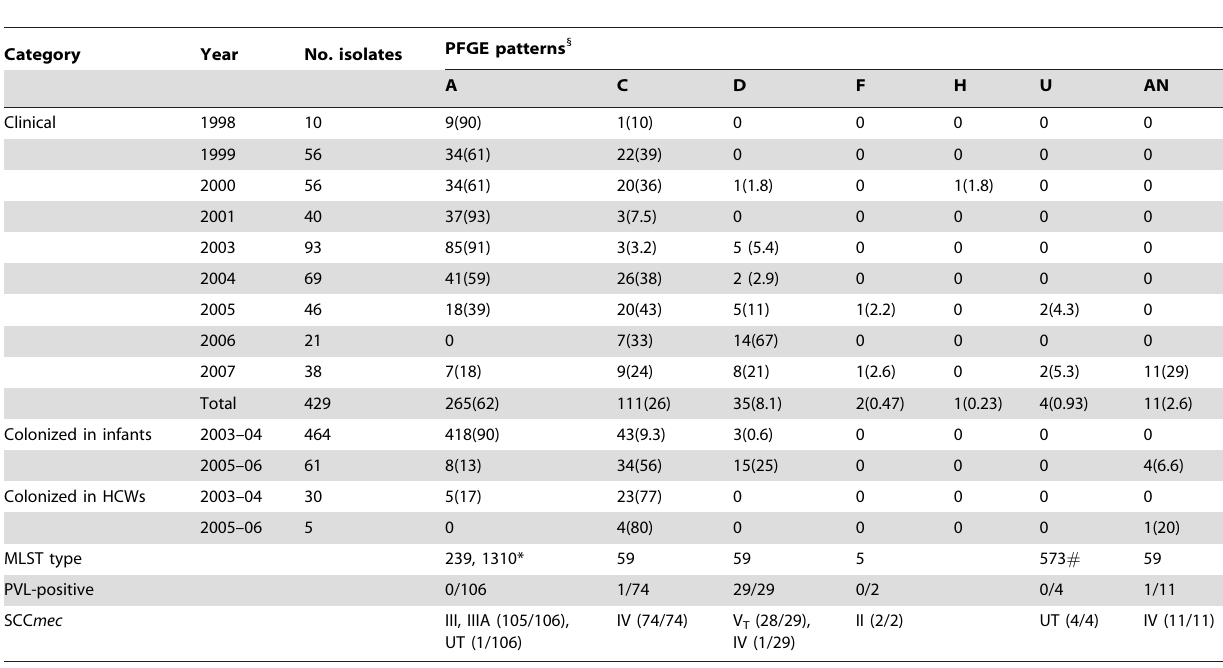
Table 4. Molecular characteristics of methicillin-resistant Staphylococcus aureus isolates from the hospitalized infants in NICUs between 1998 and